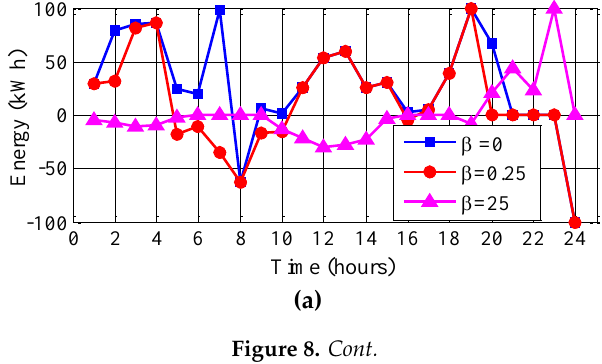
Figure 7. Cost of trading energy versus risk aversion parameter ( a ) buying from the main grid, ( b ) selling to the main grid.